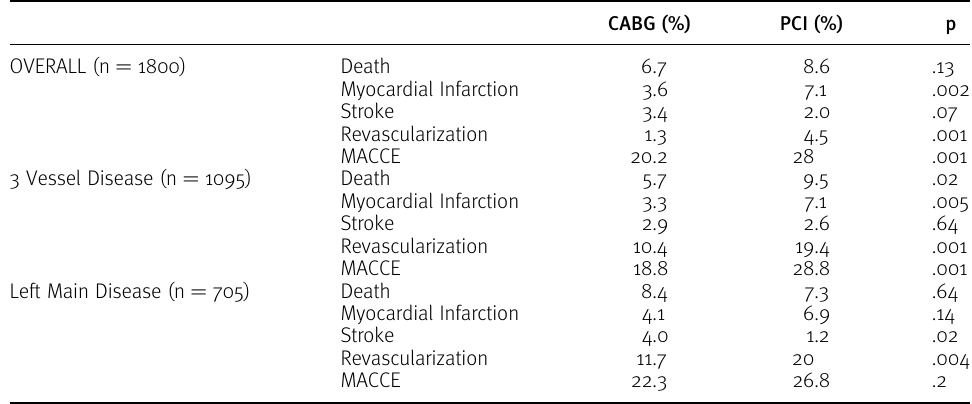
Table 4. SYNTAX at 3 YEARS (Reference